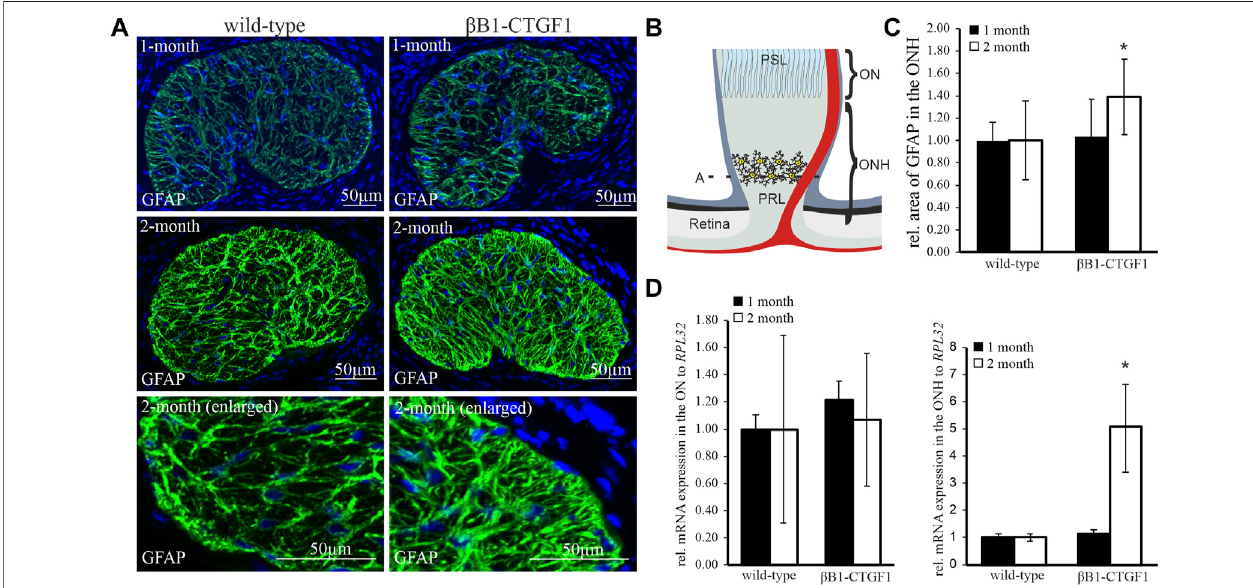
FIGURE 1 | GFAP expression and synthesis in the ON and ONH in a murine glaucoma model. (A) GFAP immunoreactivity in the glial lamina of 1-month (green, upper panel) and 2 months (green, middle and lower panel) old β B1-CTGF1 mice compared to WT controls. Immunoreactivity of GFAP was not altered in 1-month old TG and WT animals (green, upper panel). 2 month old β B1-CTGF1 mice showed an increased GFAP immunoreactivity compared to WT control (green, middle panel). Lower panel shows amagni fi ed detail ofthe middle panel. Nuclei arestained with Dapi (blue). (B) Schmatic illustration ofthe optic nerve.A depicts theregion in the glial lamina where cross sections were obtained. ONH (unmyelinated part) and ON (myelinated part) were used for molecular analysis. (C) Quanti fi cation of immunohistochemical staining of GFAP in the glial lamina is not altered in 1 month old TG and WT animals (WT: n = 5; TG: n = 4). GFAP immunoreactivity is increased in 2 montholdTGanimalscomparedtoWTlittermates(WT: n =10,TG: n =13;* p =0.039;two-tailed t -testcompared totheoreticalmeanof1(normalizedcontrol)).Mean value of WT animals (control) was set at 1. (D) RT-PCR analyses revealed no alteration in the Gfap mRNA expression in the ON of 1-month (WT: n = 7; TG: n = 5) and 2 month old β B1-CTGF1mice (WT: n = 15;TG: n =16) comparedto WTcontrols. In theONH the Gfap mRNA expression isincreasedin the 2 month old TGcompared to WT animals (WT: n = 6, TG: n = 5; * p = 0.04). The mRNA expression of Gfap is not altered in 1 month old animals (WT: n = 6, TG: n = 5). Mean value of WT animals (control) was set at 1. RPL32 was used to normalize mRNA expression. Data represented as mean ± SEM. PRL, Prelaminar region; PSL, Postlaminar region; ON, optic nerve; ONH, optic nerve head.